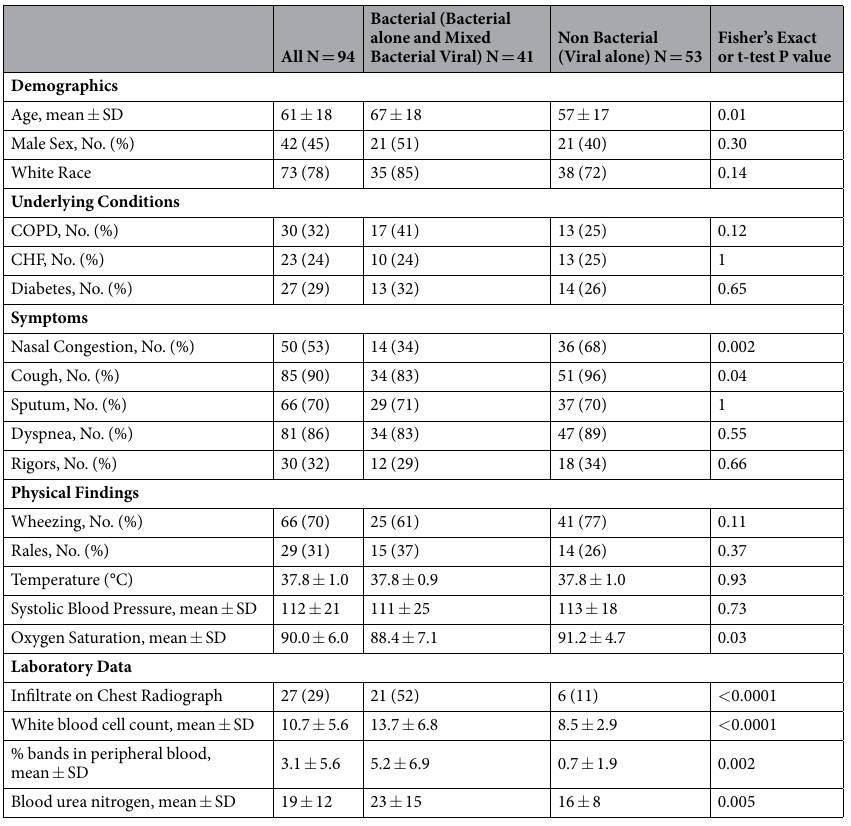
Table 2. Subject Demographic and Clinical